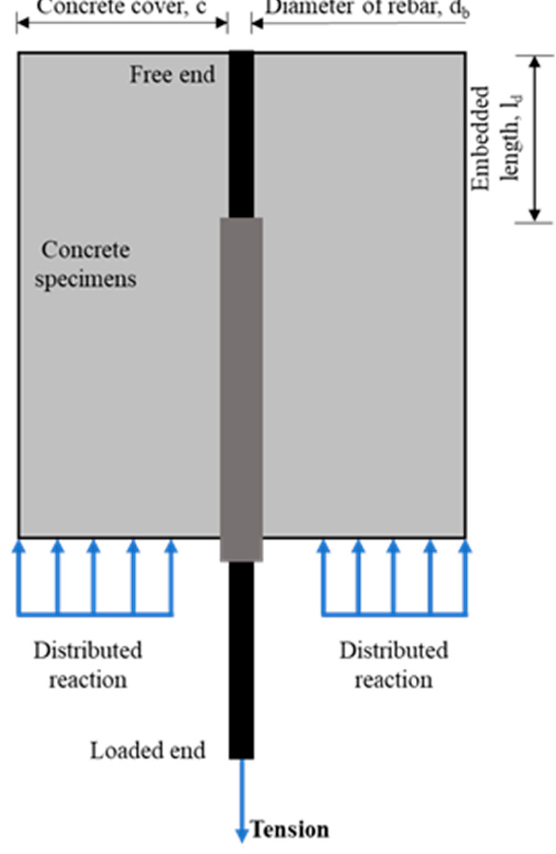
Figure 2. Schematic of typical pullout test.